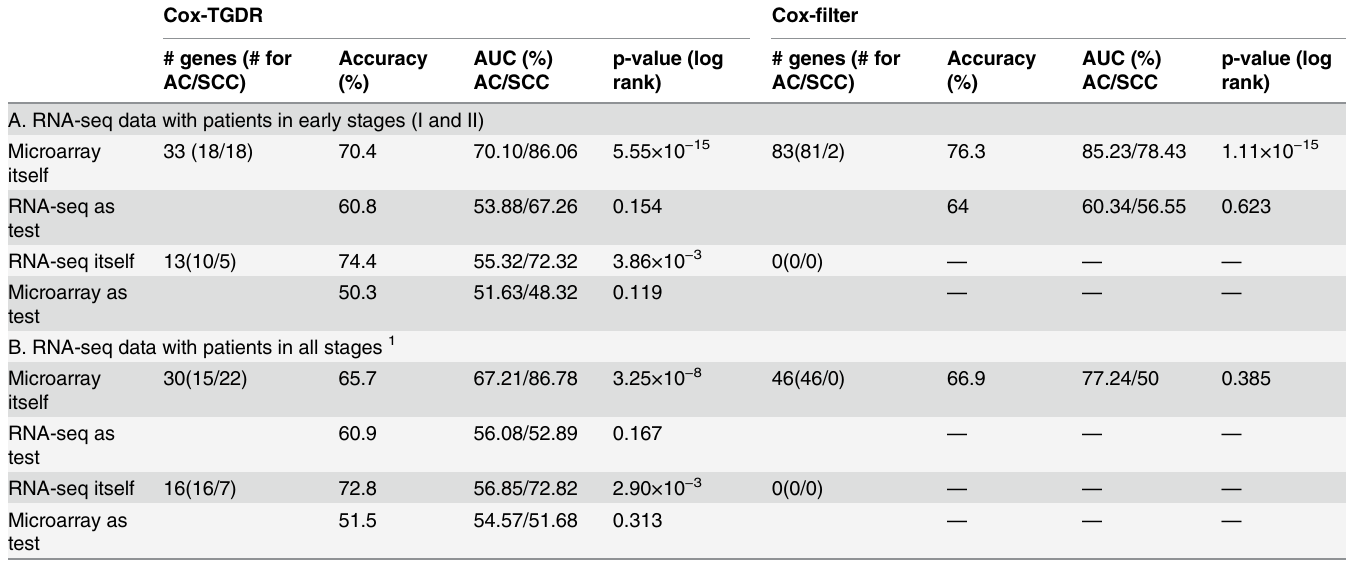
Table 1. Performance of Cox-TGDR-specific and Cox-filter on NSCLC data.